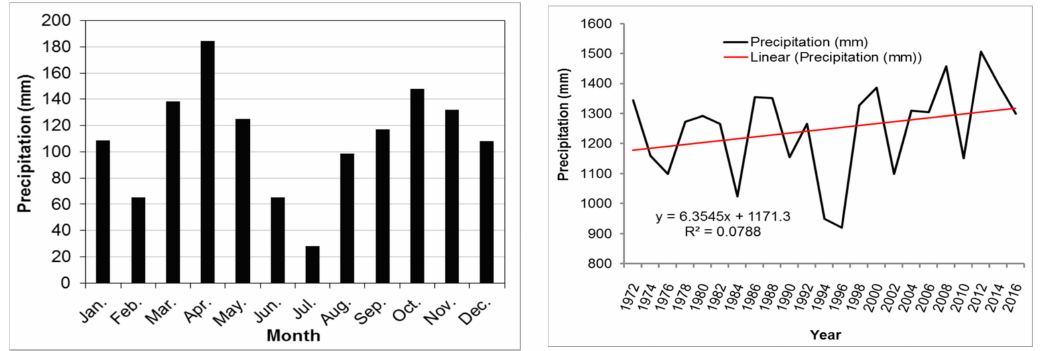
Figure 2. Monthly precipitation pattern and annual precipitation dynamics of Rwanda country from 1972 to